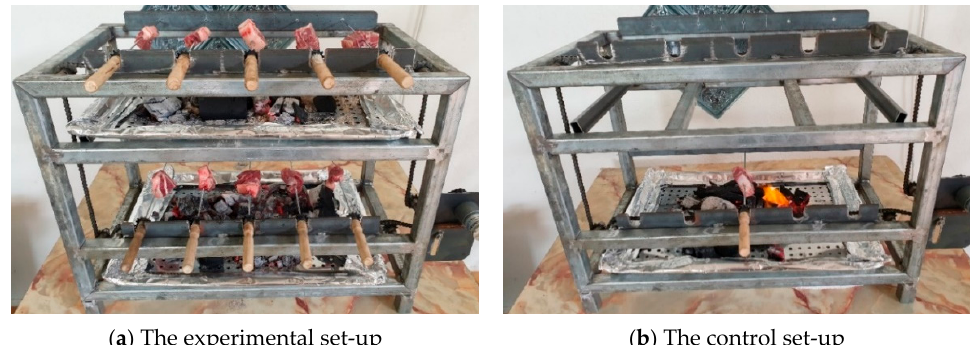
Figure 4. The prototype set ‐ up for the experiments.